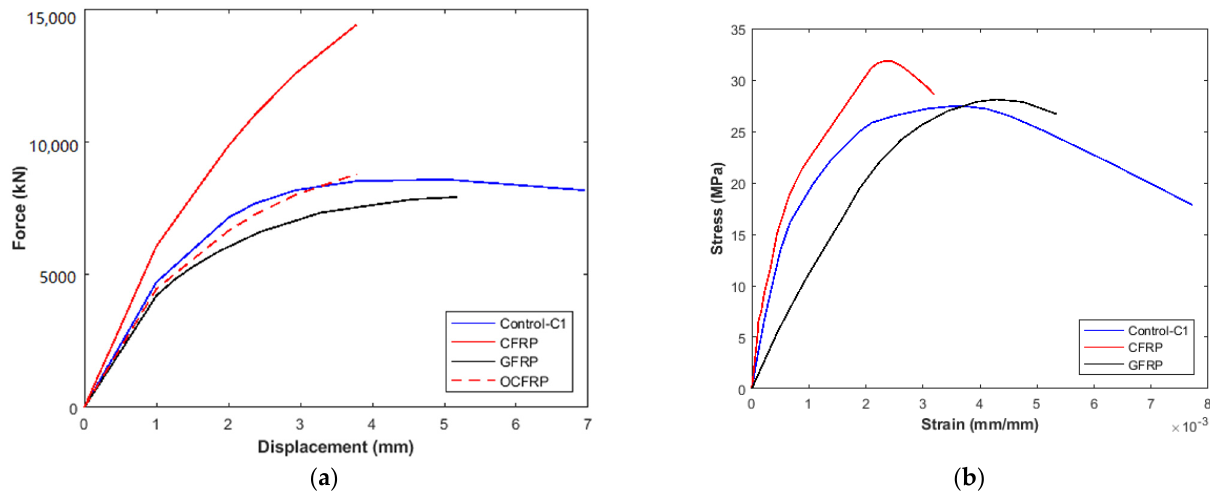
Figure 9. Group C ( a ) Load-Displacement diagram ( b ) Stress-Strain Diagram.